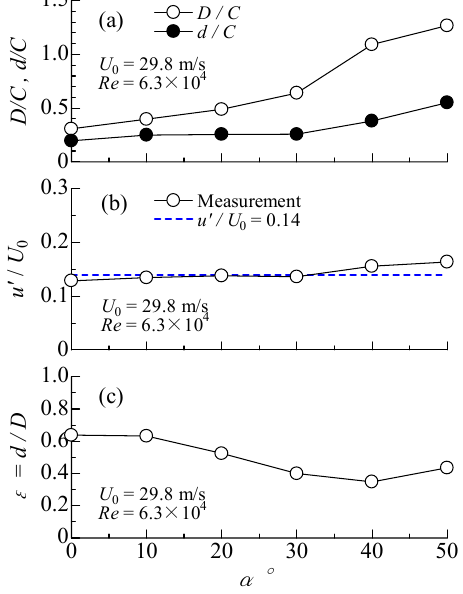
Fig.12 Relation between the angle of attack and the wake